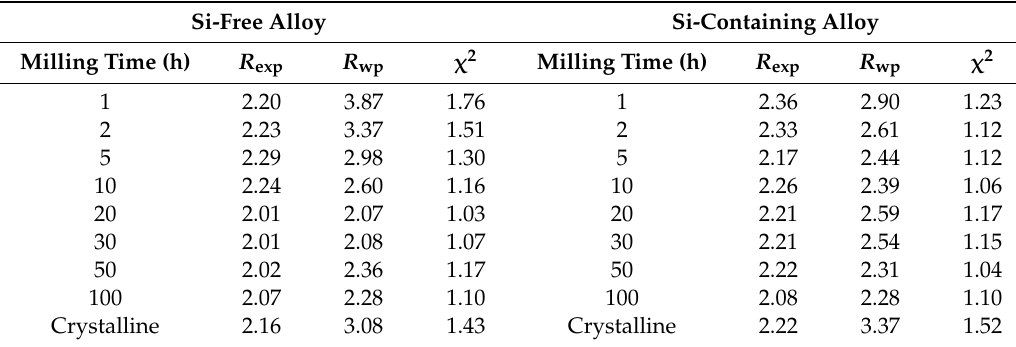
Table 1. Parameters from Rietveld fittings.